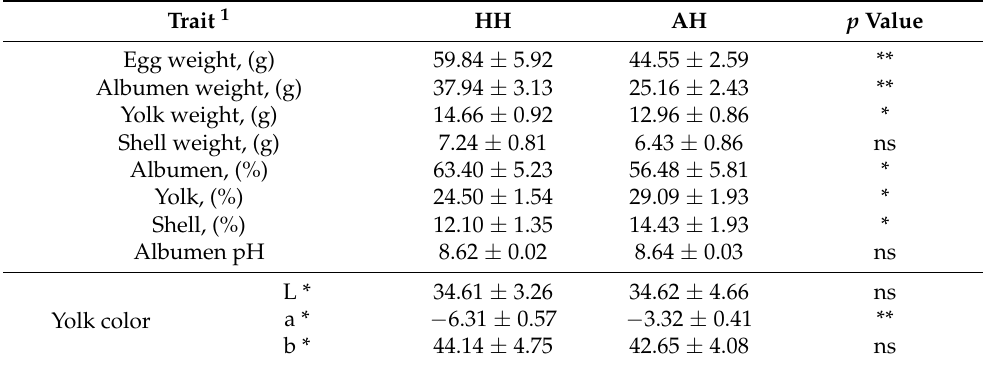
Table 2. Physical properties of eggs obtained from commercial hybrid hen (HH) and Nera Atriana laying hen (AH).